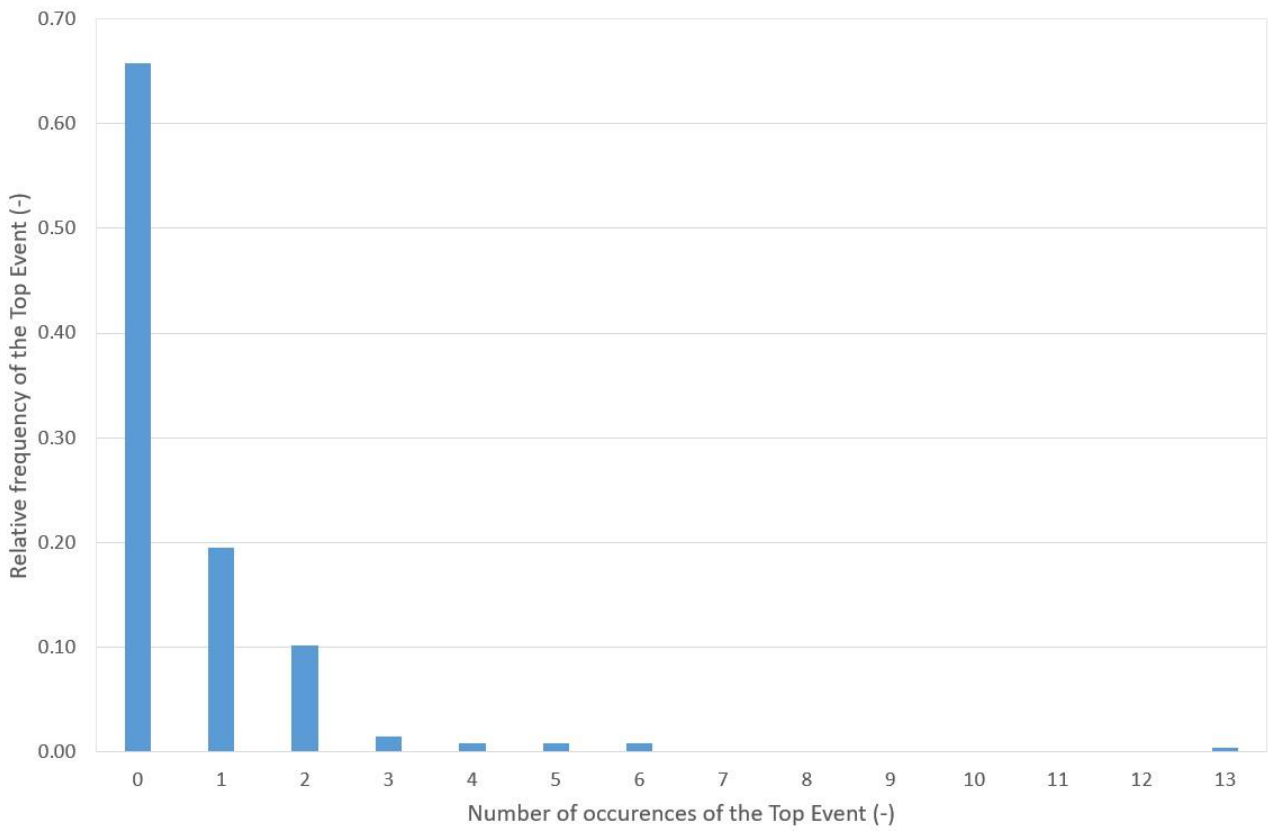
Figure 7. Relative frequency of the top event.